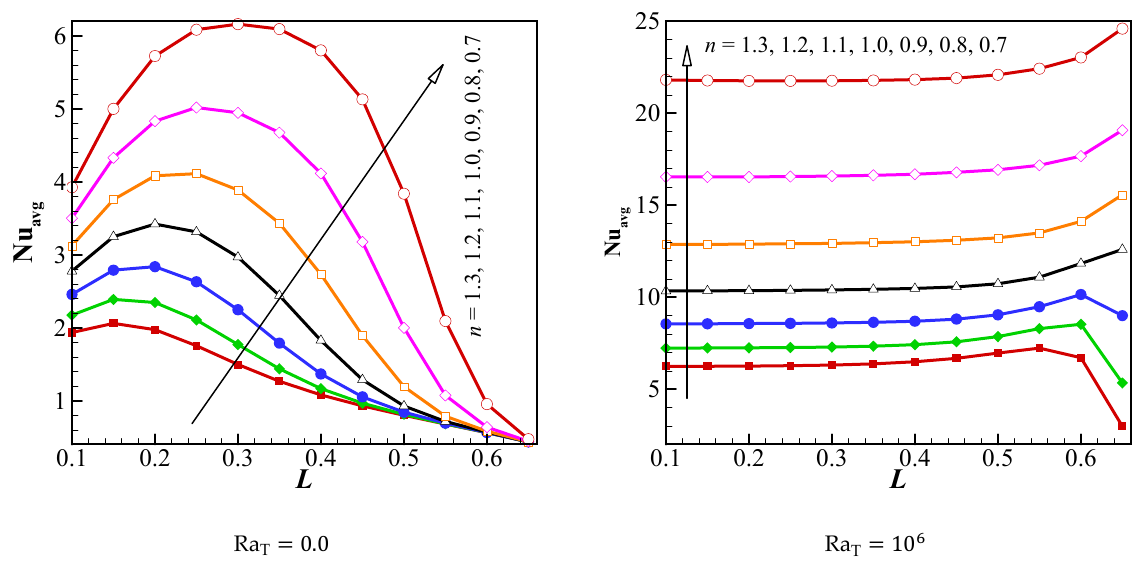
Figure 11. Dependence of the average Nusselt number, Nu avg on magnet size for different values of power lax index, n index when Ra M = 10 7 , λ = π /3, Pr = 100, Ma = 10 − 4 and β c = 60.